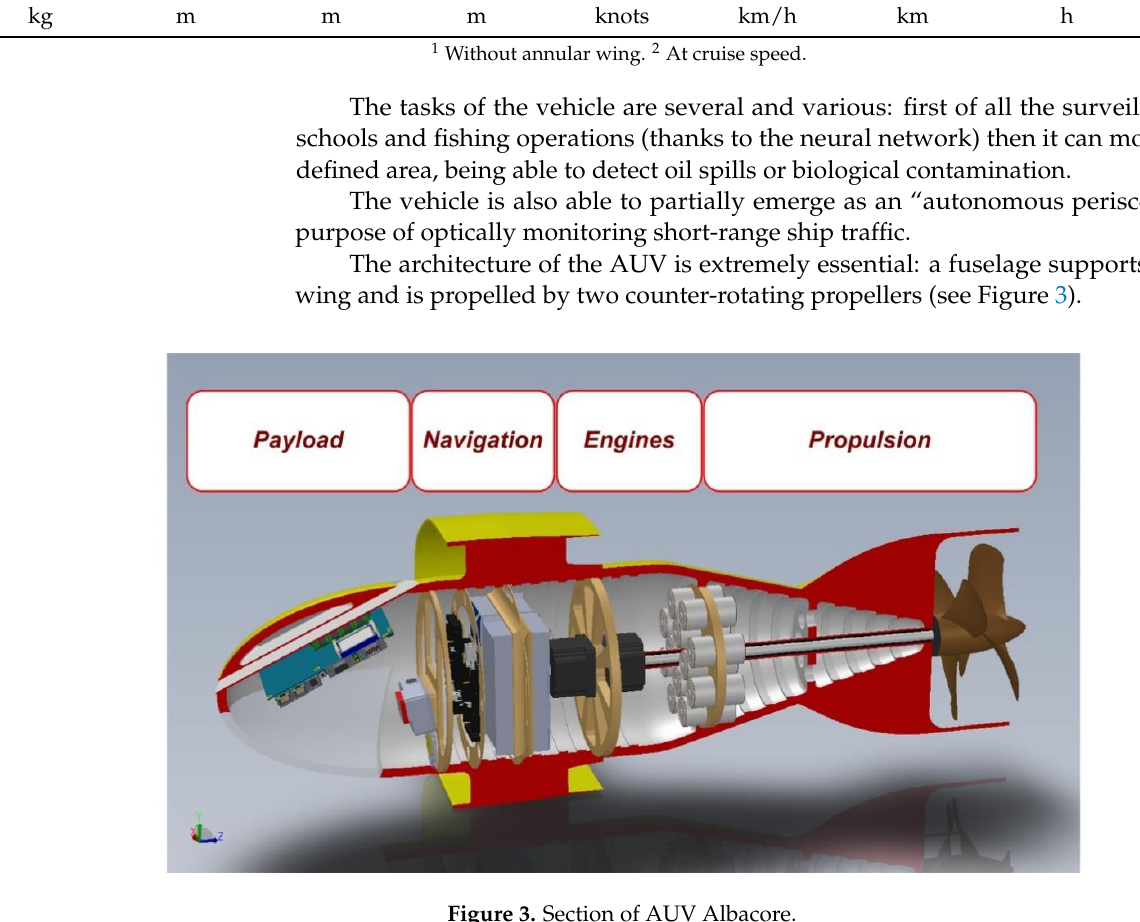
Table 1. AUV Albacore : characteristics and performances (estimated).